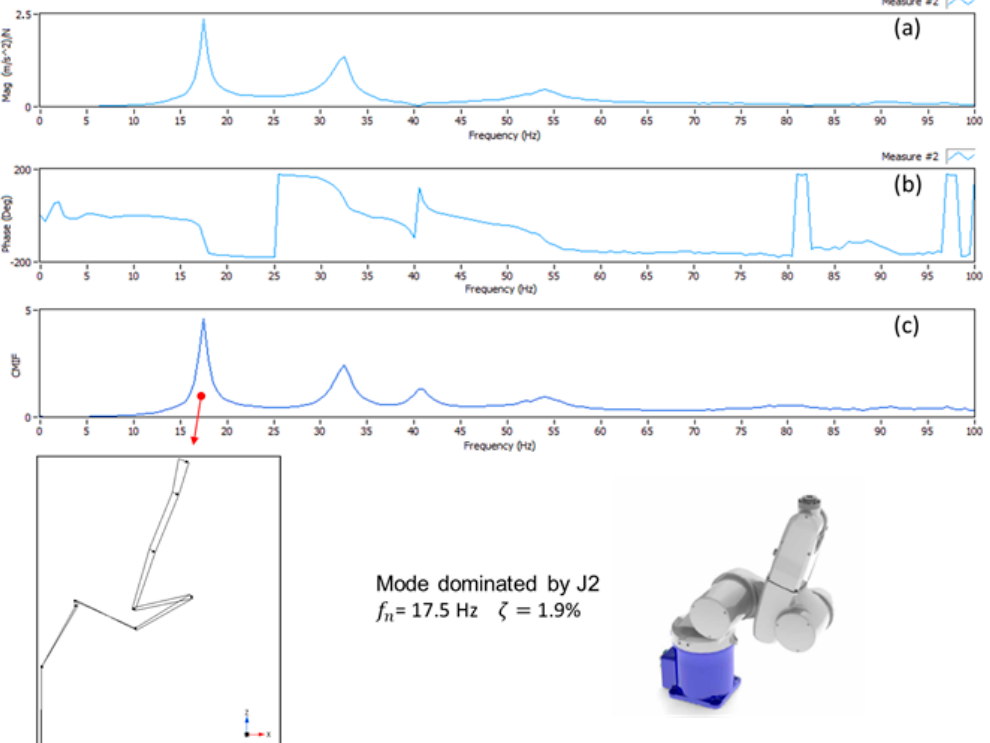
Figure 8. Test 2, ( a ) direct point frequency response function (FRF) modulus, ( b ) phase, ( c ) complex mode indicator function (CMIF).